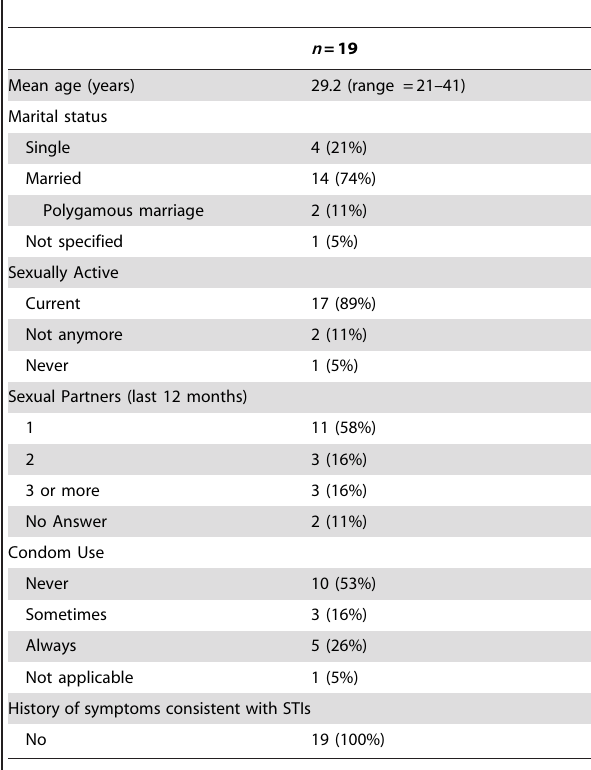
Table 1. Demographic and epidemiologic data of male